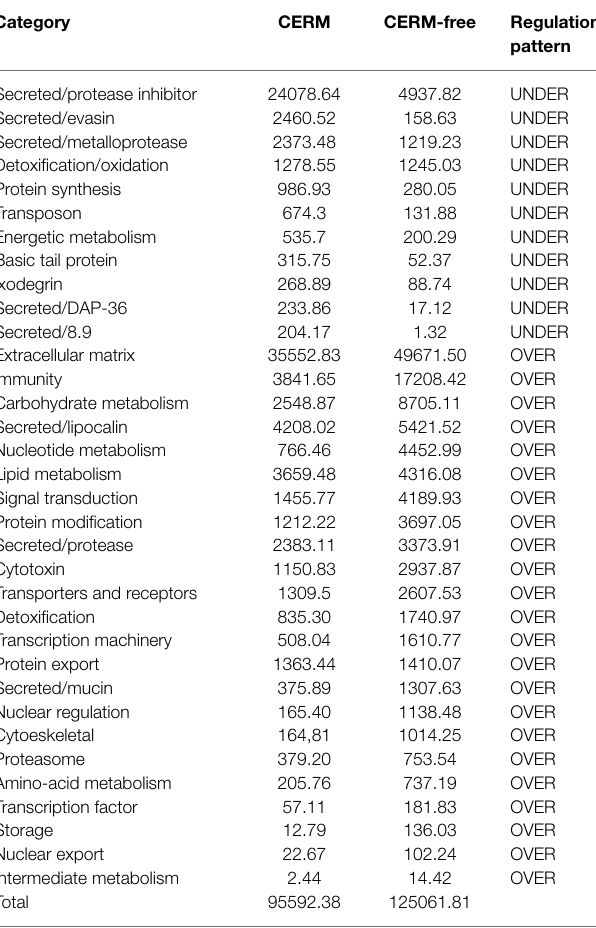
TABLE 1 | Number of transcripts IDs differentially expressed in CERM ( Coxiella endosymbiont from R. microplus )-free metanymphs grouped into functional